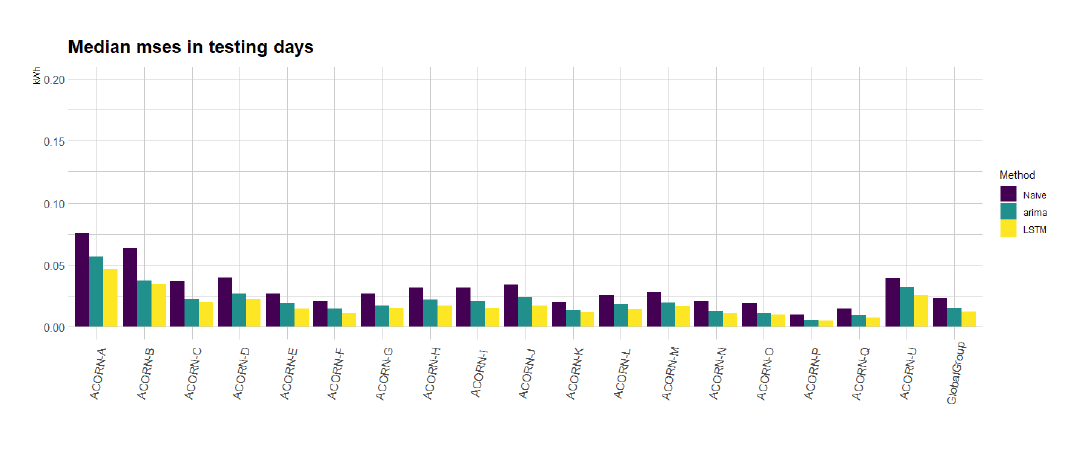
Figure 14. Out-of-sample performance for testing